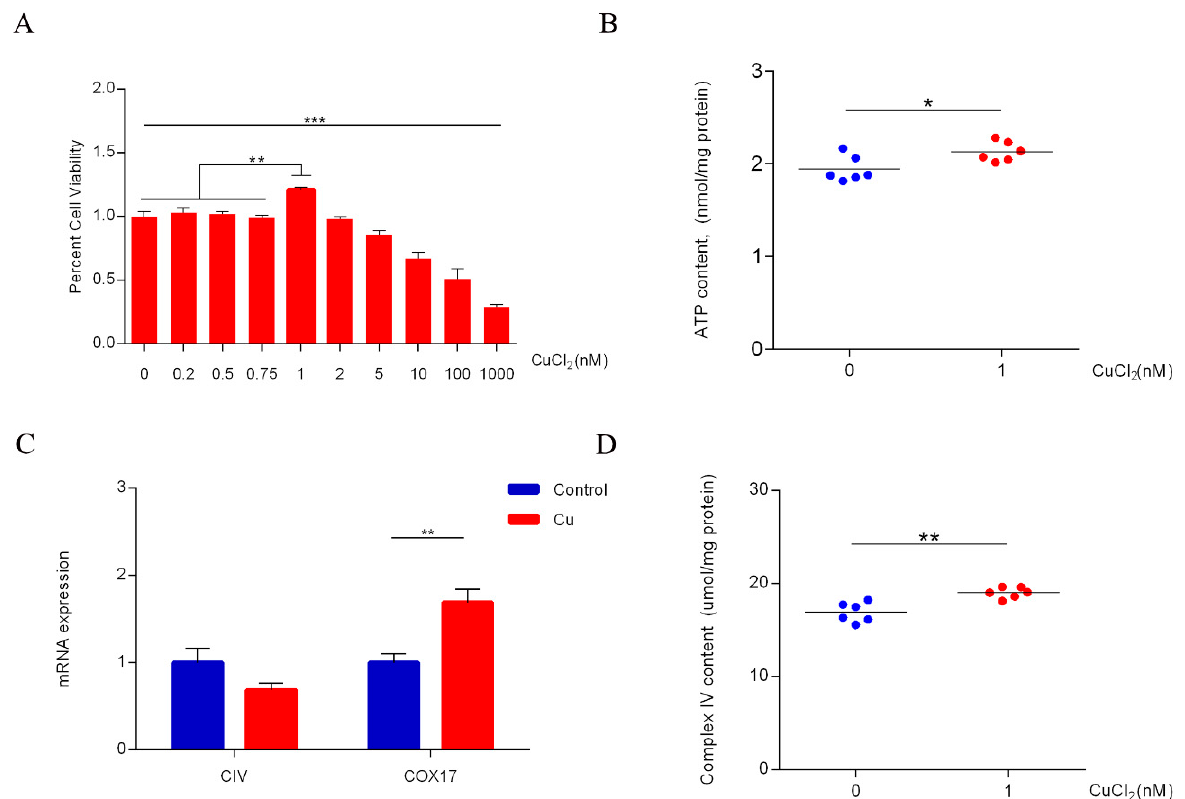
Figure 1. ( A ) CCK-8 assay for cell viability with increasing copper concentration; dermal papilla cells were serum starved in DMEM overnight followed by addition of different amounts of CuCI 2 for 24 h ( n = 6). Significance was calculated using One-way ANOVA with Tukey post-test for comparing multiple groups. * p < 0.05, ** p < 0.01, *** p < 0.001. ( B ) Measurement of intracellular adenosine triphosphate (ATP) content; dermal papilla cells were serum starved in DMEM overnight followed by addition of CuCI 2 for 24 h ( n = 6). Analysis was performed by unpaired two-sided t -test. * p < 0.05. ( C ) qPCR analysis showing transcript levels of cytochrome c oxidase subunit 1 (CIV) and cytochrome c oxidase copper chaperone (COX17) in control and copper (1 nM)-treated dermal papilla cells, treated with copper for 1 h ( n = 6). Analysis was performed by unpaired two-sided t -test. ** p < 0.01. ( D ) Measurement of intracellular Complex IV content; dermal papilla cells were serum starved in DMEM overnight followed by addition of CuCI 2 for 24 h ( n = 6). Analysis was performed by unpaired two-sided t -test. ** p < 0.01.